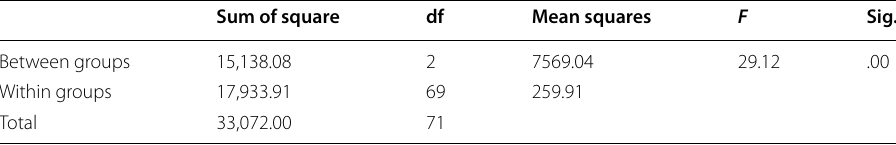
Table 14 Inferential statistics of the three groups on the motivation post-tests Sum of square df